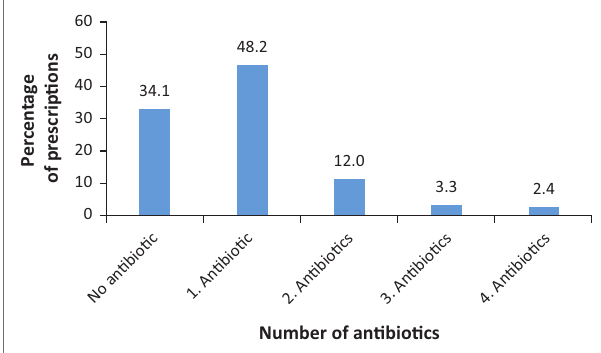
FIGURE 1: Number of antibiotics prescribed in each prescription.